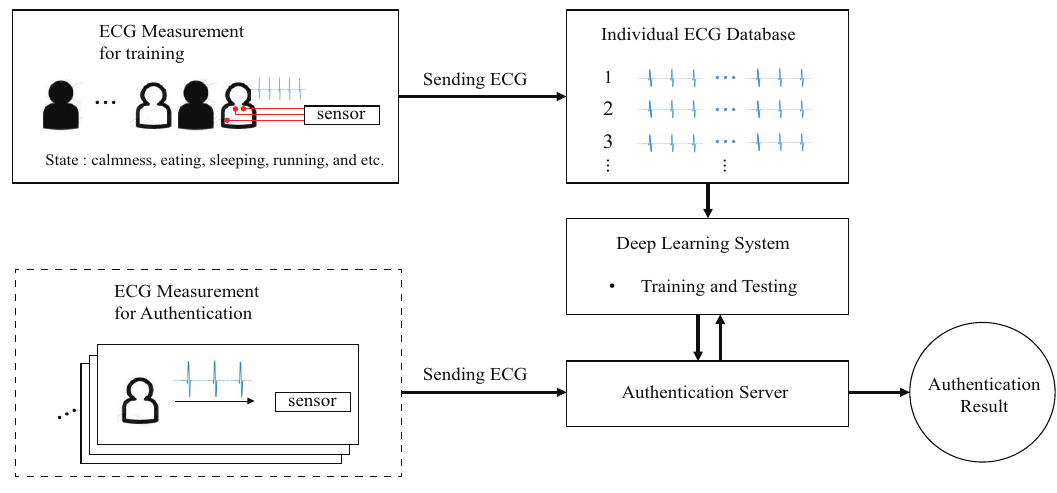
Figure 1. Conventional personal authentication system using